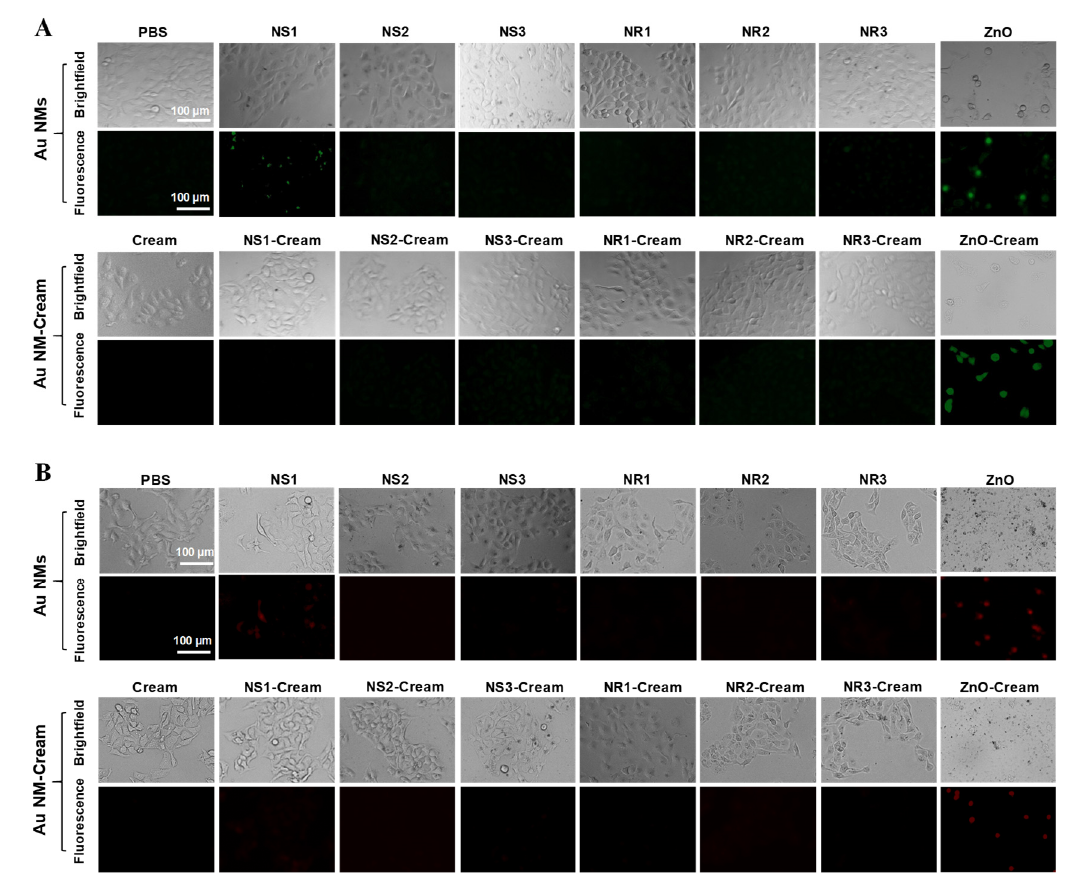
Figure 5. Fluorescence images to evaluate mitochondrial dysfunction induced by Au NMs and Au NM − Cream. ( A ) Mitochondrial membrane potential evaluated by JC-1; ( B ) mitochondrial superoxide generation evaluated by MitoSox Red. HaCaT cells were treated with 0.18 μ g cm − 2 Au NMs and Au NM − Cream (equivalent to Au surface area doses) for 24 h, and ZnO or ZnO − Cream was used as the positive control.